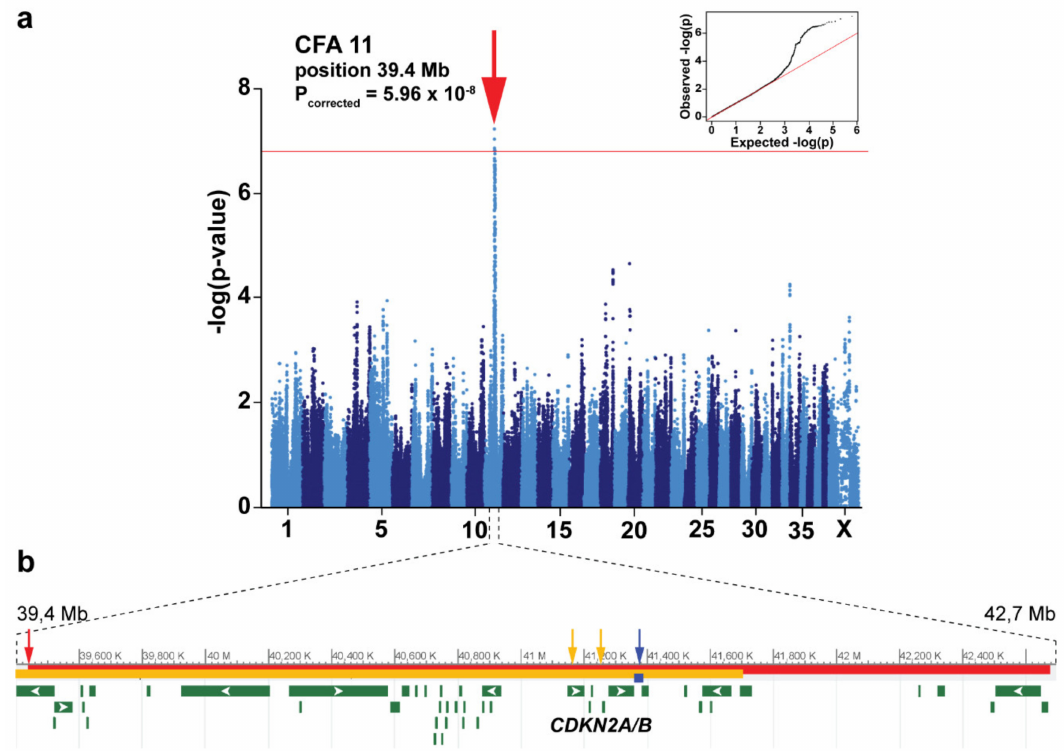
Figure 2. ( a ) Manhattan plot of the GWAS results using 273 OSA-cases and 365 controls shows an OSA-associated locus in Leonbergers on dog chromosome (CFA) 11. The − log p -values for each SNP are plotted on the y-axis and the position on each chromosome on the x-axis. The red line represents the Bonferroni-corrected significance threshold ( − log( p -value) =